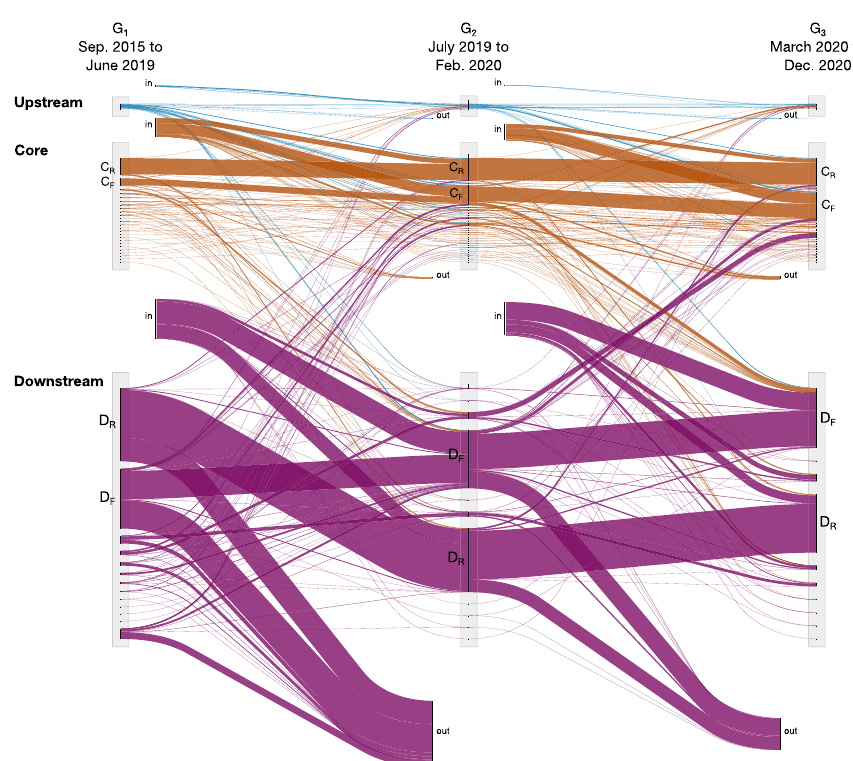
Fig. 7 Alluvial diagram of the evolution of the communities across the three periods. Flows represent the movement of channels from community to community across time. New channels entering and existing in the system are represented as arriving from “in” and “out” groups, respectively. The upstream, core and downstream communities are grouped in three different bundles and shown in different